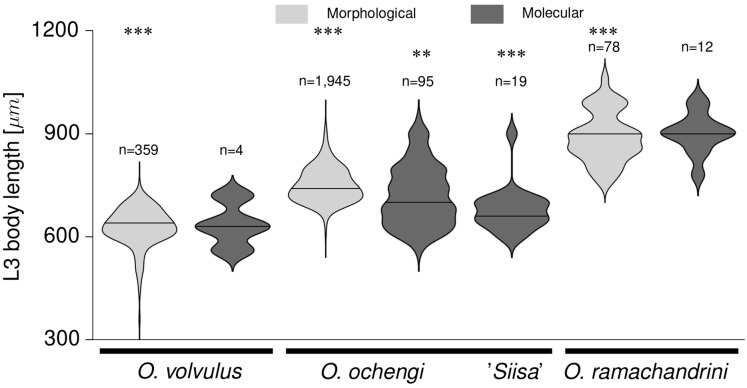
L3 body lengths.Violin plot of the L3 body lengths of identified Onchocerca spp. in S. damnosum s.l. from North Cameroon. Species identification is based on morphological (light grey) and molecular-genetic (dark grey) characteristics. Two genotypes of O. ochengi, O. ochengi s. str. and O. ochengi 'Siisa', are shown based on their mitochondrial clades. ***P < 0.001; **0.01 > P > 0.001; *P < 0.05.